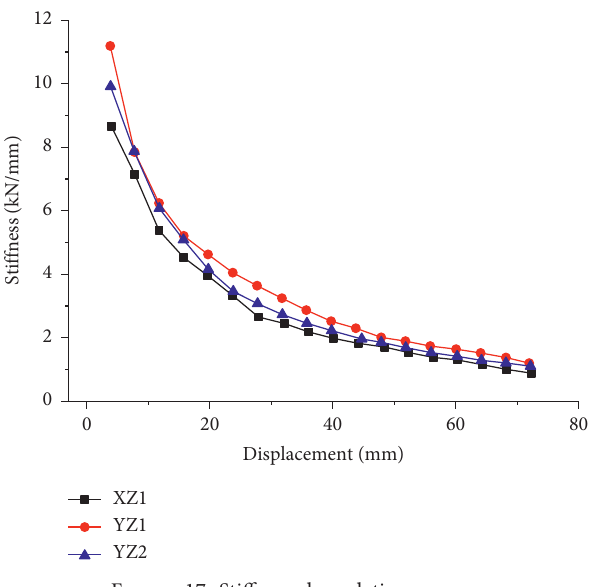
Figure 17: Stiffness degradation curves. Table 9: Secant stiffness of the specimens at the major characteristic states (kN/mm).